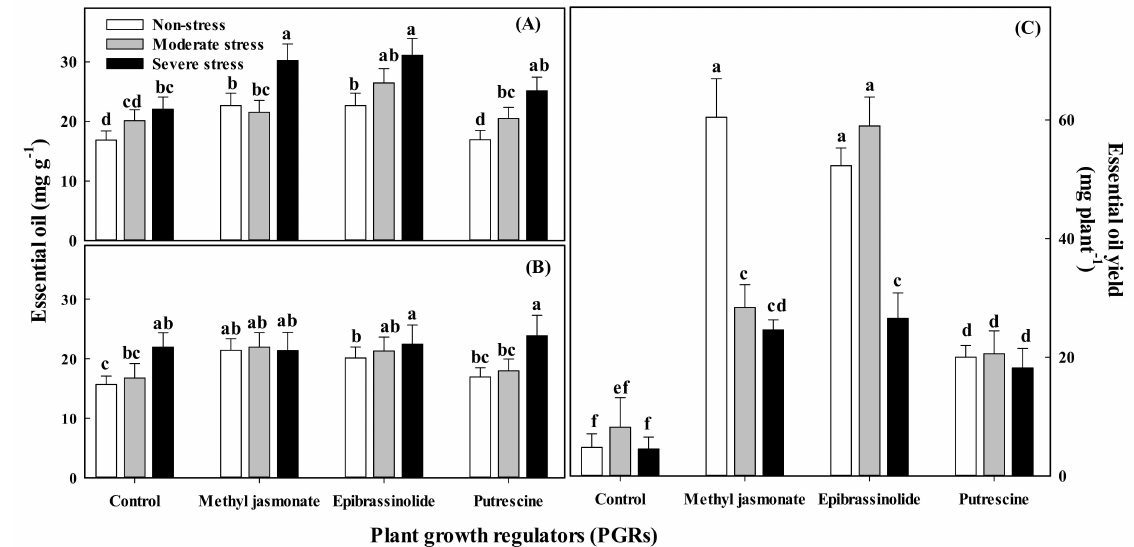
Figure 2. Effect of water stress and plant growth regulators applied at the ( A ) vegetative or ( B ) gener- ative stage of fennel (Foeniculum vulgare Mill.) on essential oil content ( A , B ) and essential oil yield in vegetative stage ( C ). Data are means ( n = 3), and bars represent standard errors of the mean. In each panel, means with same letter (a, b, c, . . . ) do not differ significantly ( p <